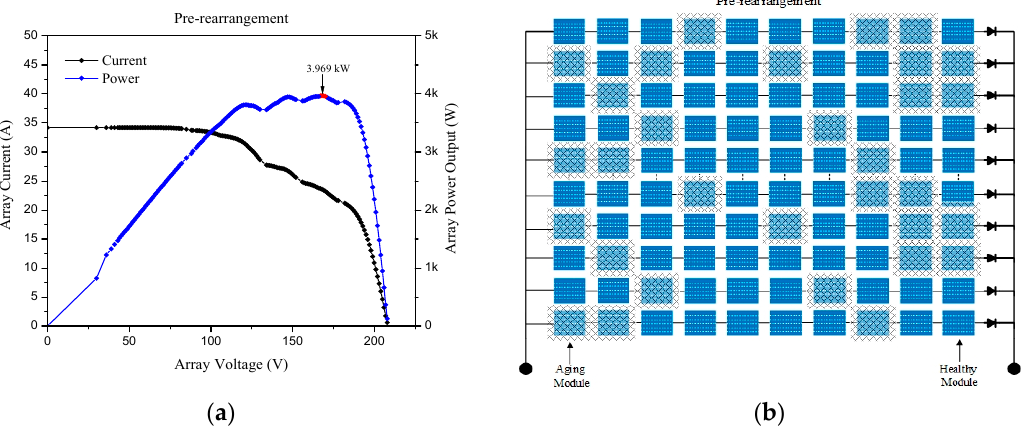
Figure 3. The output result for the 10 × 10 PV array. ( a ) PV array without rearrangement. ( b ) The aging modules were covered with a plastic cap for clarification. Table 3. PV array 10 × 10 parameters after arrangements.